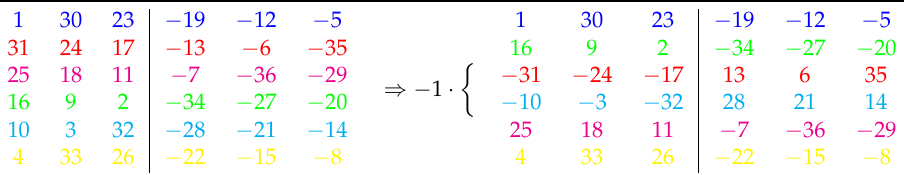
Table 13. Winding Distribution Table for a symmetrical reduced winding with N = 36, m = 6, p = 5 and q = 3 / 5 .